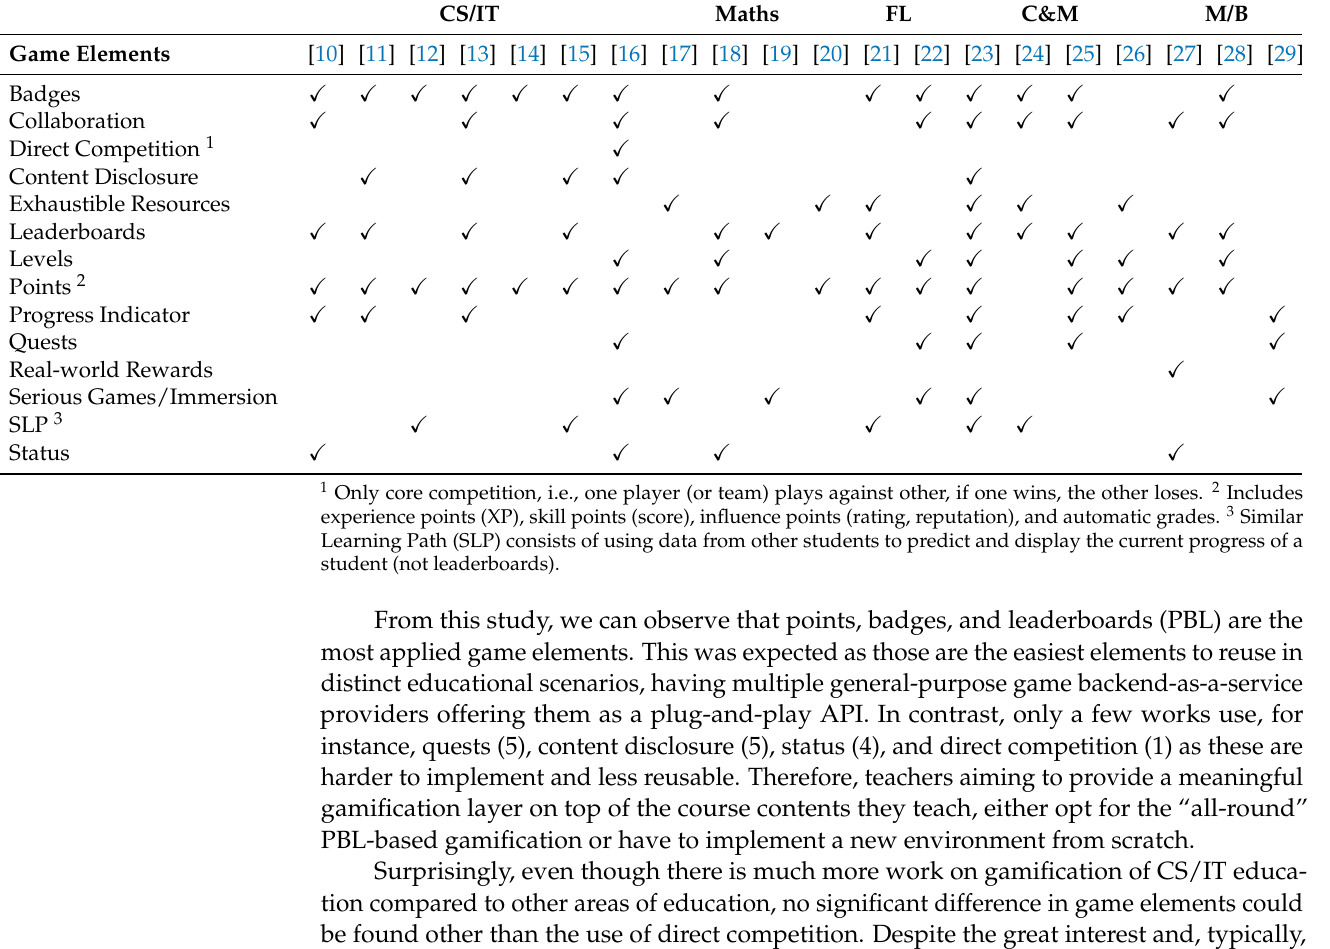
Table 1. Game elements reported in the selected research papers. CS/IT Maths FL C&M